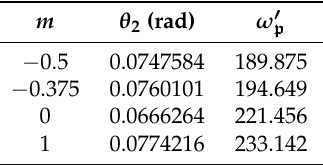
Table 4. Cavitation angles θ 2 and the normal forces ω (cid:48) p , computed for m = − 0.5, − 0.375,0,1 when (cid:101) = 0.01.